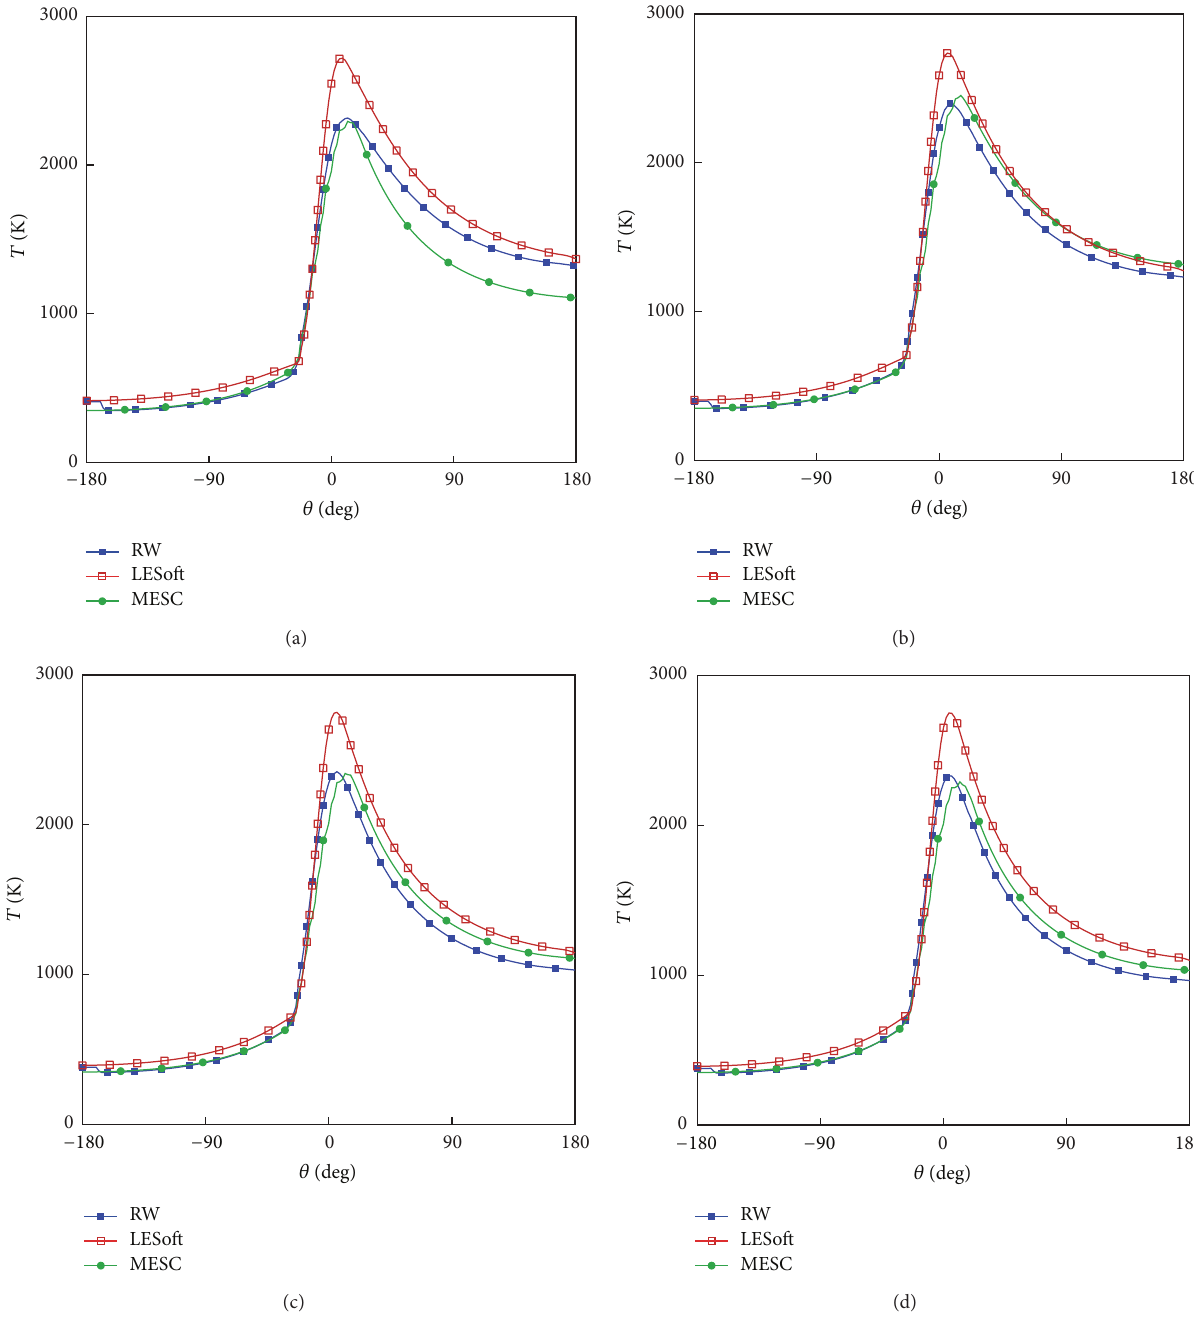
the peak pressure and the peak temperature in the